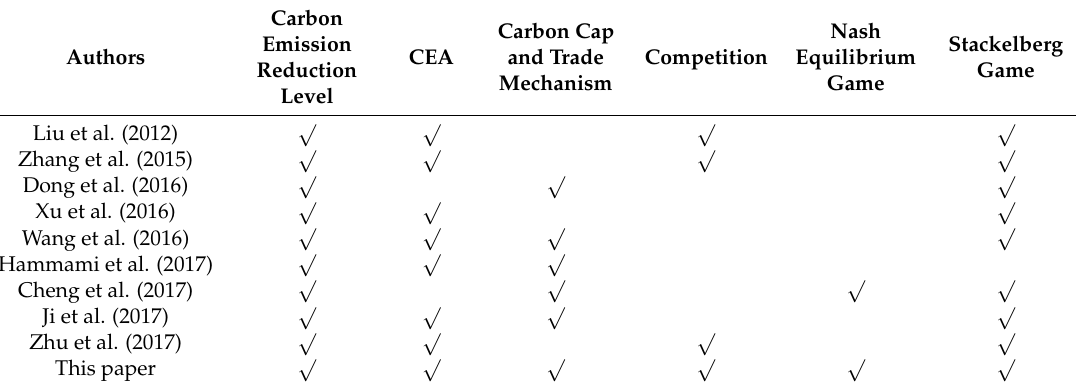
Table 1. Comparison of previous models with this